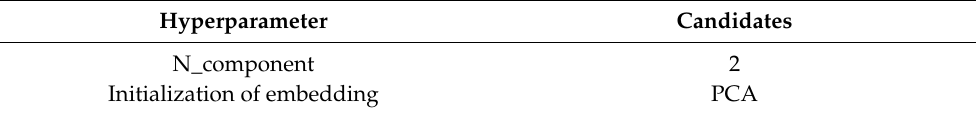
Table 3. t-SNE hyperparameters. Table 3. t ‐ SNE hyperparameters.